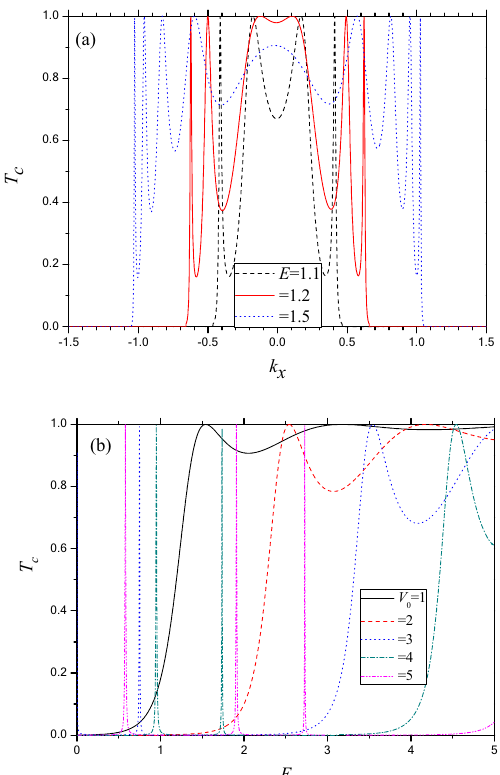
Figure 3. ( a ) T c as a function of the x-component of wave vector ( k x ) through a static phosphorene electrostatic barrier along Г–Y direction for D = 5 and V 0 = 1. Dash (black) line for E = 1.1; Solid (red) line for E = 1.2; Dot (blue) line for E = 1.5. ( b ) T c v.s. E for barrier along Г–Y direction with D = 1 and k x = 0.001. Solid (black) line for V 0 = 1; Dash (red) line for V 0 = 2; Dot (blue) line for V 0 = 3; Dash dot (green) line for V 0 = 4; Dash dot dot (purple) line for V 0 =